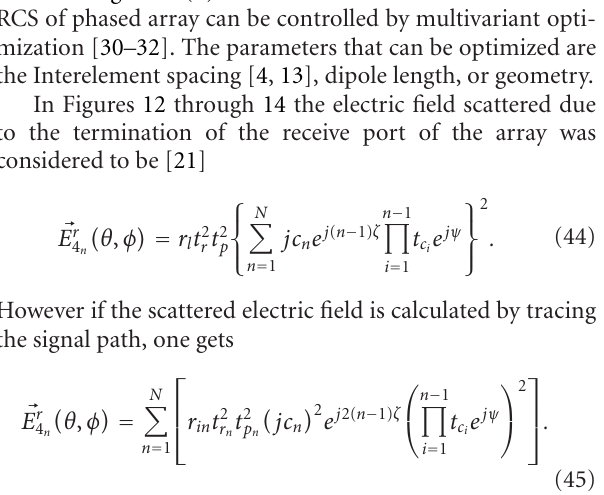
Figure 10: Path of the signal traveling towards the load terminating its own